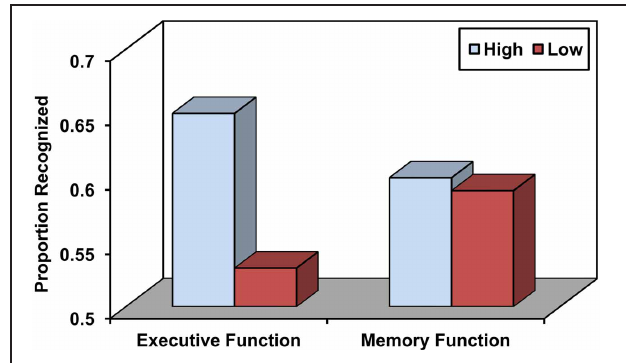
FIGURE 1 | Source memory in older adults as a function of high and low executive function and memory function. Adapted from Glisky et al.